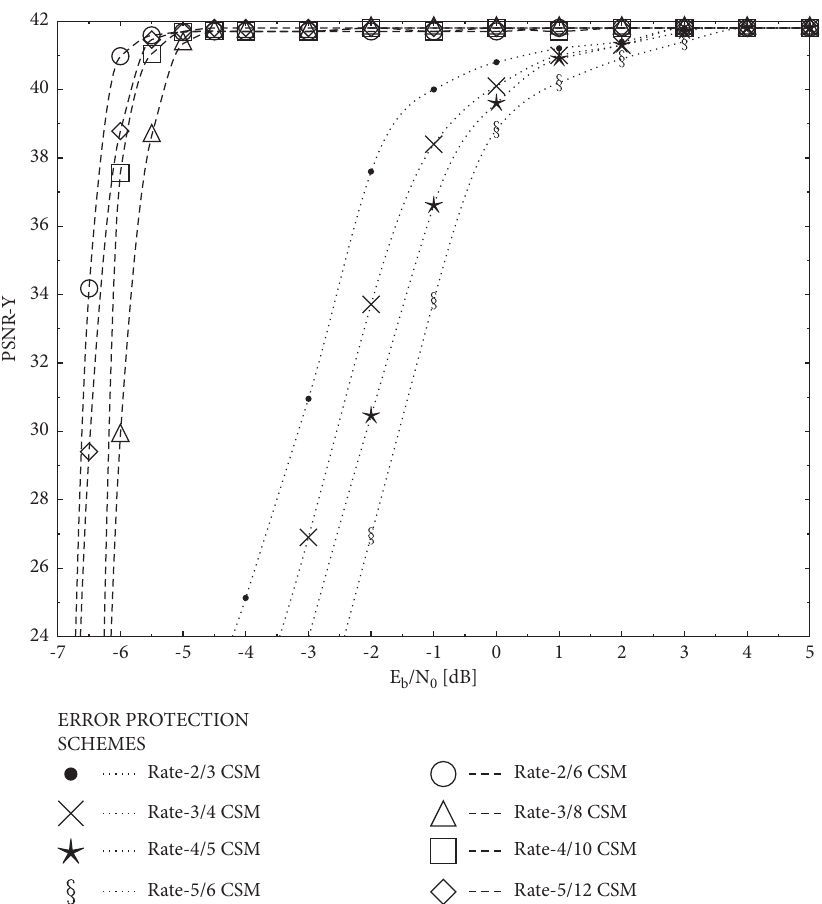
Figure 14: PSNR performance curves of CSM based schemes presented in Table